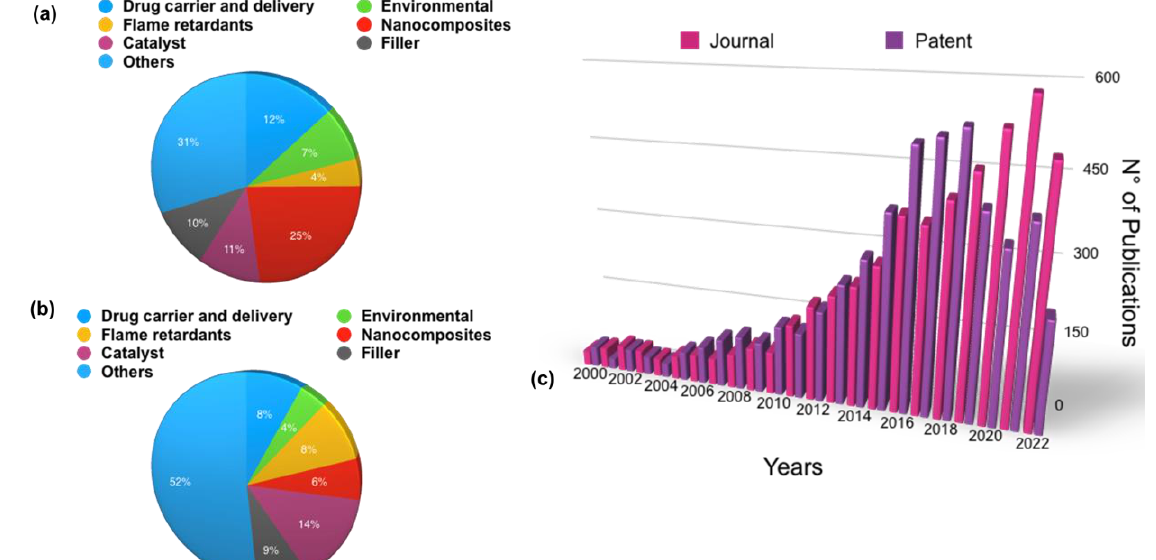
Figure 5. Comparison of the number of ( a ) scientific publications and ( b ) patents on the different applications fields of halloysite; ( c ) distribution (%) of scientific publications in “ patent ” and “ journal ” for halloysite. Data analysis of publications in October 2022 was performed using the SciFinder Scholar search system using searches for “ Document type ” the “ Journal ” and “ Patent ” , respectively.